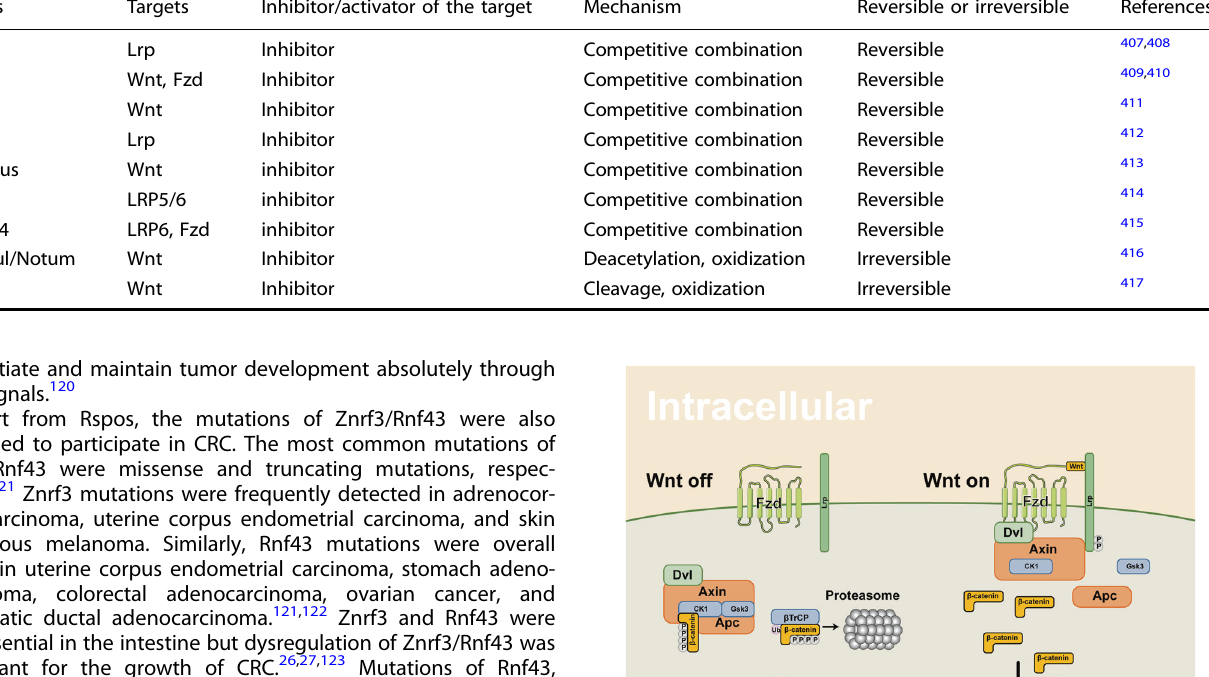
Table 1. The mammalian endogenous repressors of Wnt/ β -catenin signaling Factors